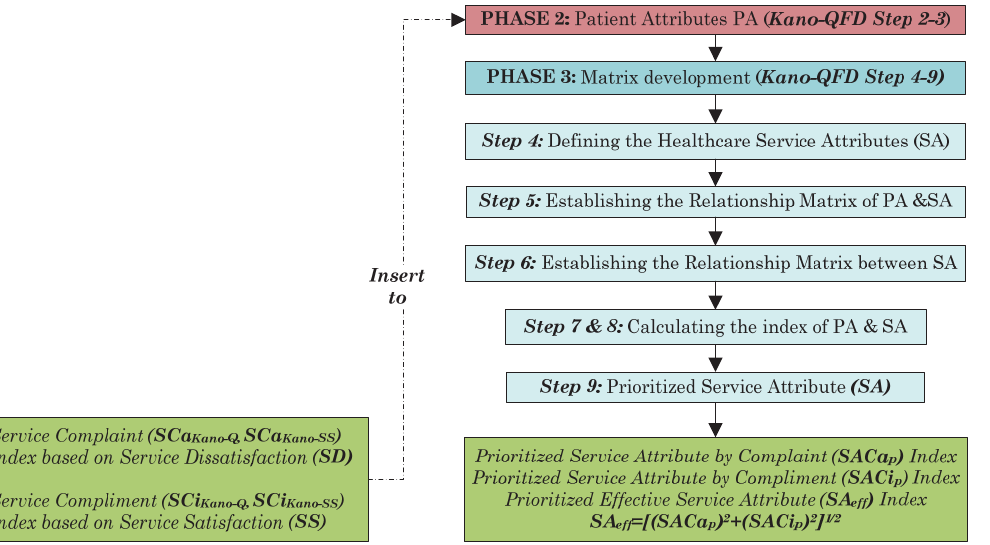
Fig. 1. The flow of Kano-QFD execution for Phase 2 and 3